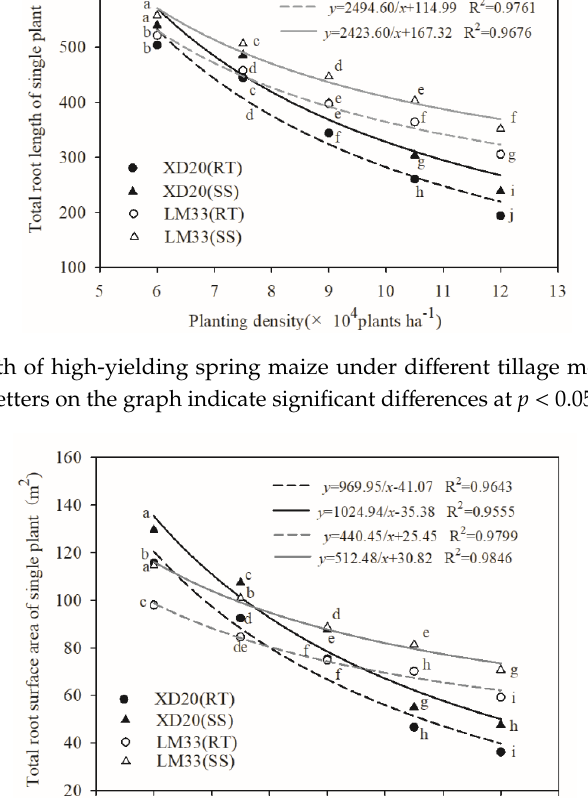
Figure 3. Root surface area of high-yielding spring maize under different tillage methods and planting densities. Different letters on the graph indicate significant differences at p < 0.05.